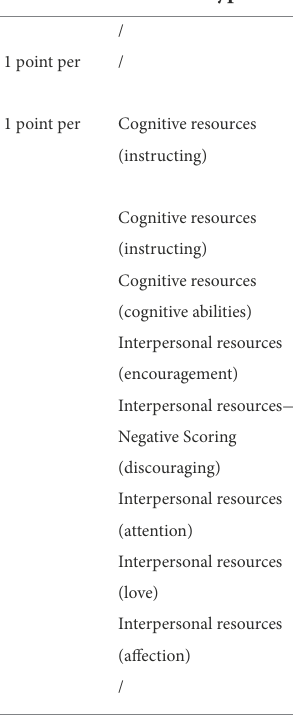
TABLE 1 Video coding dimensions and specific indicators for parent–child interaction and grandparent–child interaction. Coding